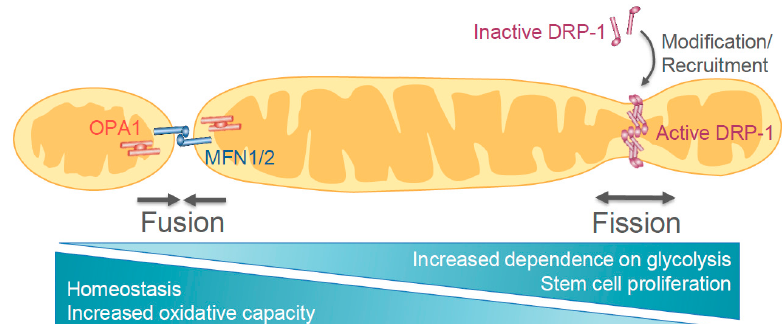
Figure 2. Mitochondrial dynamics are regulated by several large guanosine triphosphatases (GTPases). Mitochondrial fusion is mediated by the activity of mitofusins (MFN) 1 and MFN2 at the outer mitochondrial membrane, while optic atrophy 1 (OPA1) regulates fusion of the inner mitochondrial membrane. Fission occurs through recruitment of active dynamin-related protein 1 (DRP-1) to receptors at the outer mitochondrial membrane by various mechanisms, including phosphorylation, ubiquitination, and sumoylation. Stem cells have high mitochondrial fragmentation mediated through DRP ‐ 1 activity [54].